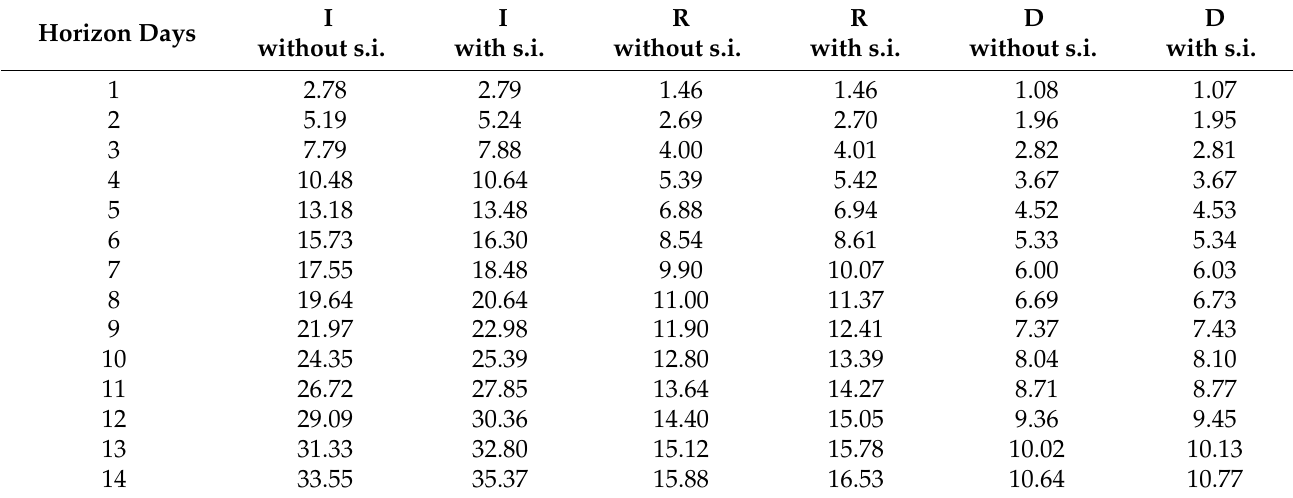
Table 4. MAPE values-DTW aggregation training with and without stringency